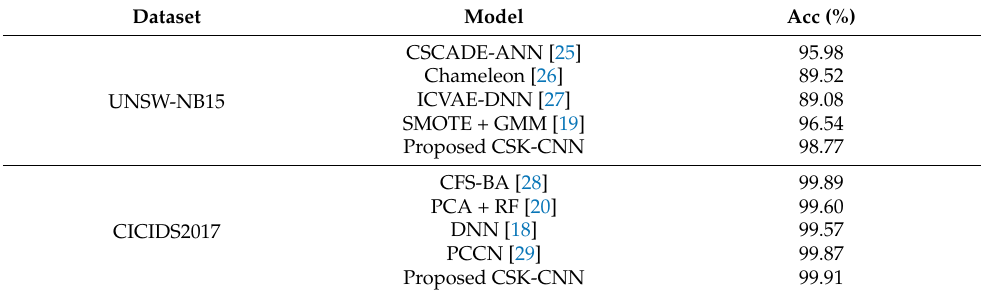
Table 9. A comparison of proposed CSK-CNN with the current state-of-the-art